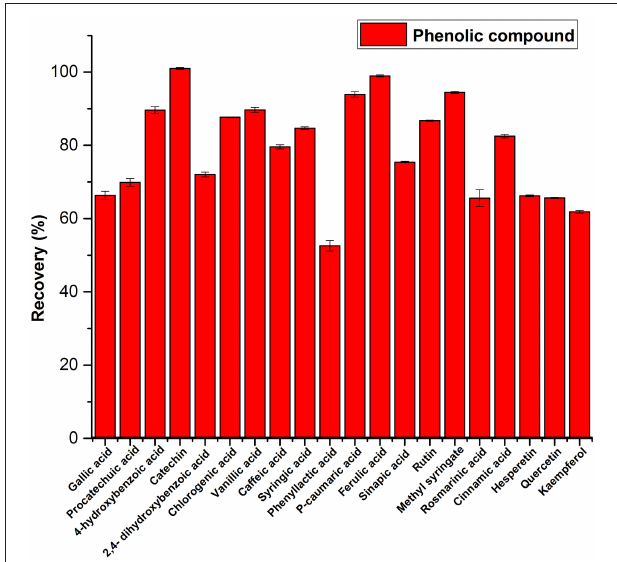
FIGURE 3 | Recovery of phenolic compounds from spiked artificial honey.